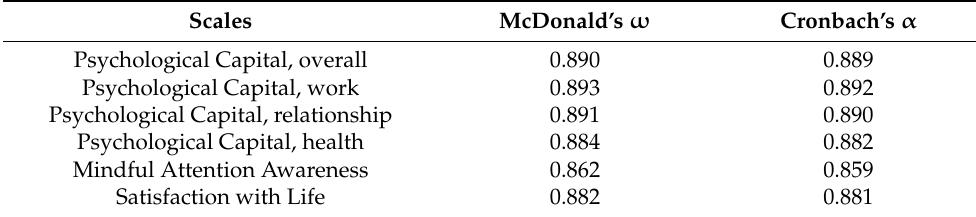
Table 1. Cronbach alphas and McDonald’s omegas for the SWLS, the PCQ-12, and the MAAS. Scales